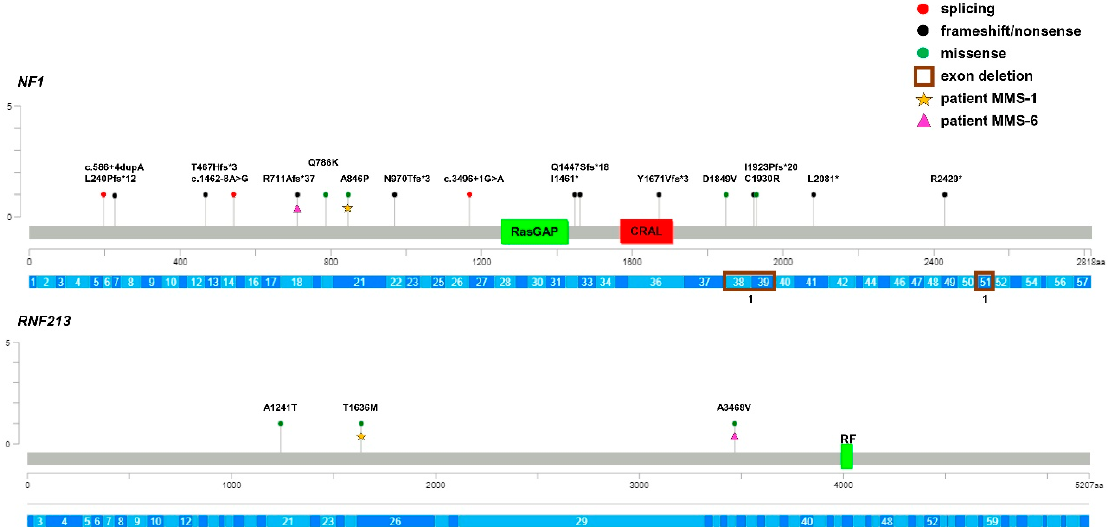
Figure 1. Lolliplot graph showing distribution and frequency of NF1 and RNF213 variants identi- fied in MMS patients. Yellow star and violet triangle identify variants carried by the same patient. RasGAP: Ras GTPase activating protein domain; CRAL: CRAL-TRIO lipid-binding domain (cellular retinaldehyde-binding protein and TRIO guanine exchange factor); RF: RING finger domain; aa: num- ber of protein amino acids; c.: number of nucleotides in the coding region of the gene. * stop codon. The gene exons are schematized in dark and light blue. Number 1 under the brown rectangle (exonic deletions) indicates the number of the patients who were carriers of exonic copy number